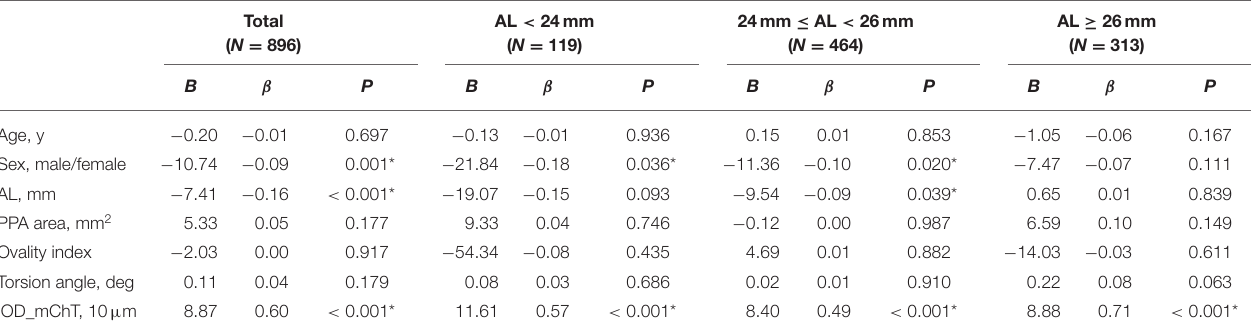
TABLE 4 | Multivariate regression analysis of association with macular choroidal thickness in all subjects and groups with different degrees of